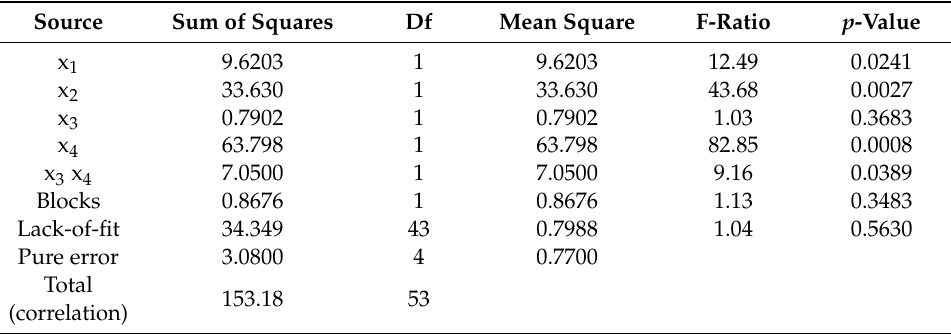
Table 3. Analysis of variance: the empirical model for predicting